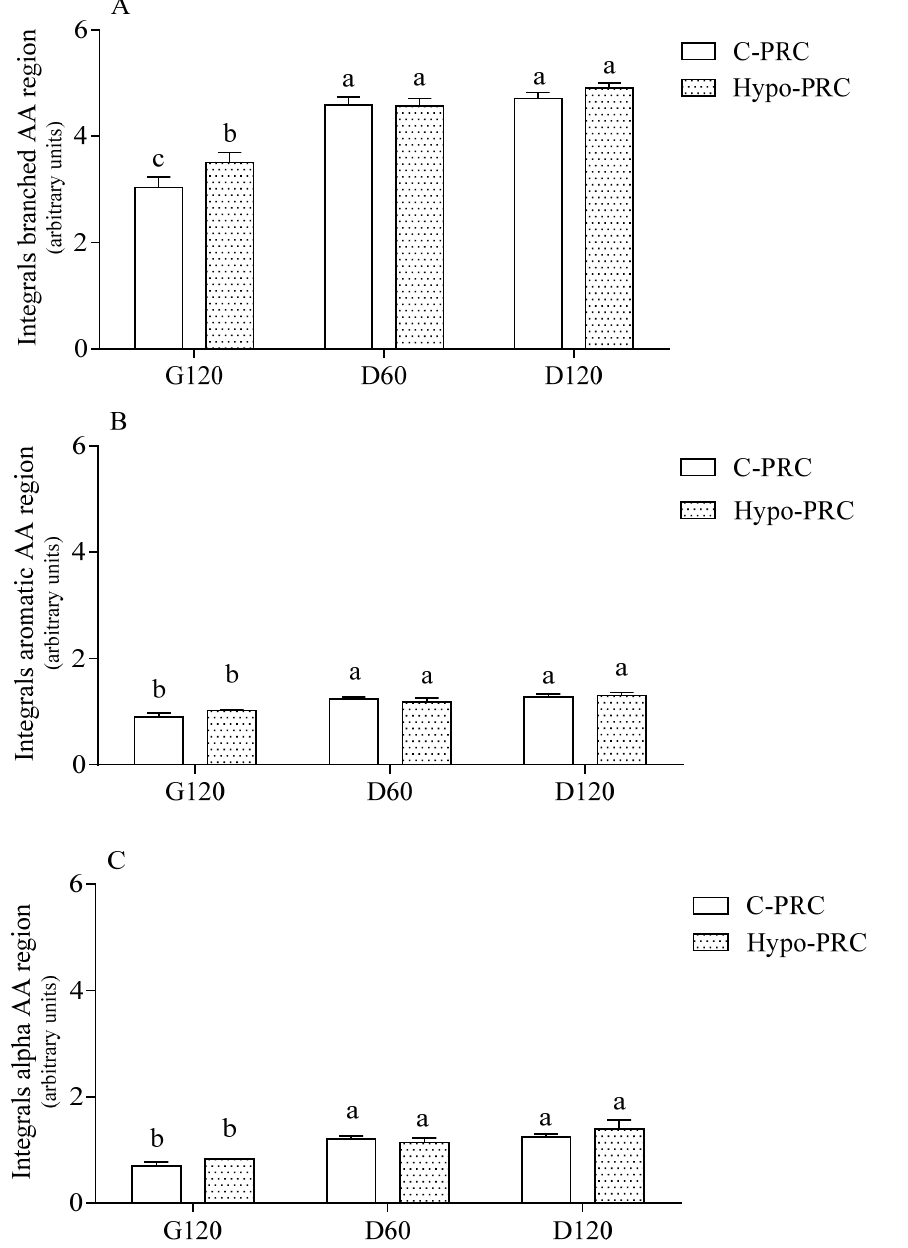
Figure 3. Integral area of branched ( A ), aromatic ( B ), and α -proton ( C ) amino acid region in conven- tional Parmigiano Reggiano cheese (C-PRC) and hyposodic Parmigiano Reggiano cheese (Hypo-PRC) at different digestion times. Data are means ± SD of 3 independent in vitro digestions, each one in triplicate. Integrals are expressed as arbitrary units. Statistical analysis was by the one-way ANOVA (all integrals p < 0.0001) with Tukey’s post-hoc test (different letters indicate significant differences). G120: end of gastric phase; D60: 60 min of duodenal phase; D120: end of duodenal